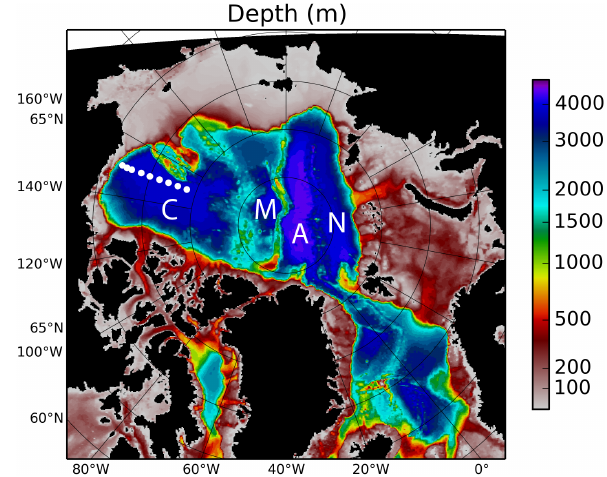
Figure 1. Bathymetry (m) of the Arctic Ocean and environs. The four major basins of the deep Arctic Ocean are labelled: Cana- dian (C), Makarov (M), Amundsen (A), Nansen (N). Representative station positions from the BGEP along 150 ◦ W are shown as white